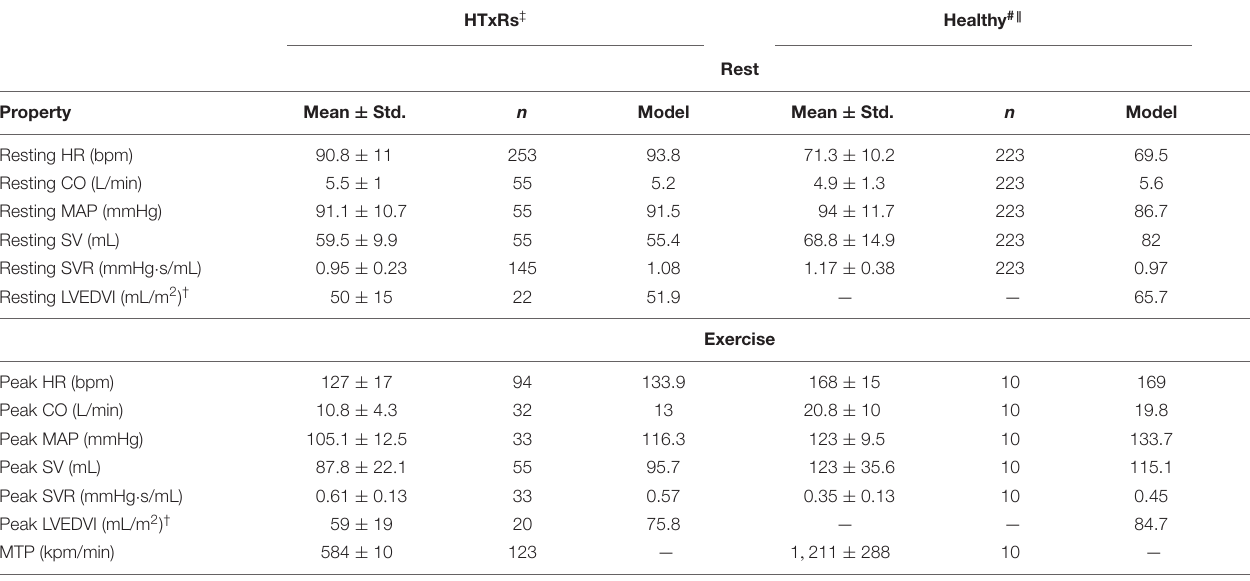
TABLE 2 | Pooled means and variances of hemodynamic variables for HTxRs and an age- and gender-matched healthy control cohort compared to the simulation results for the purpose of model validation. HTxRs ‡ Healthy # (cid:107) Rest